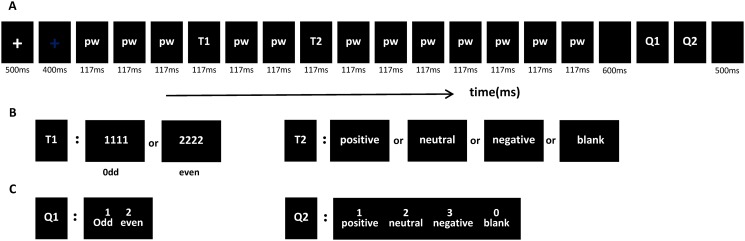
The RSVP paradigm used in this experiment.All words were in Chinese (containing pseudo-words and emotional nouns; see supplementary material for more details), and (A) each trial contained 12 pseudo-words (pw), two target stimuli (T1 and T2), and two questions (Q1 and Q2). The time interval between T1 and T2 was 234 ms. (B) Example for the two target stimuli in each trial. (C) Example for the two questions in each trail.